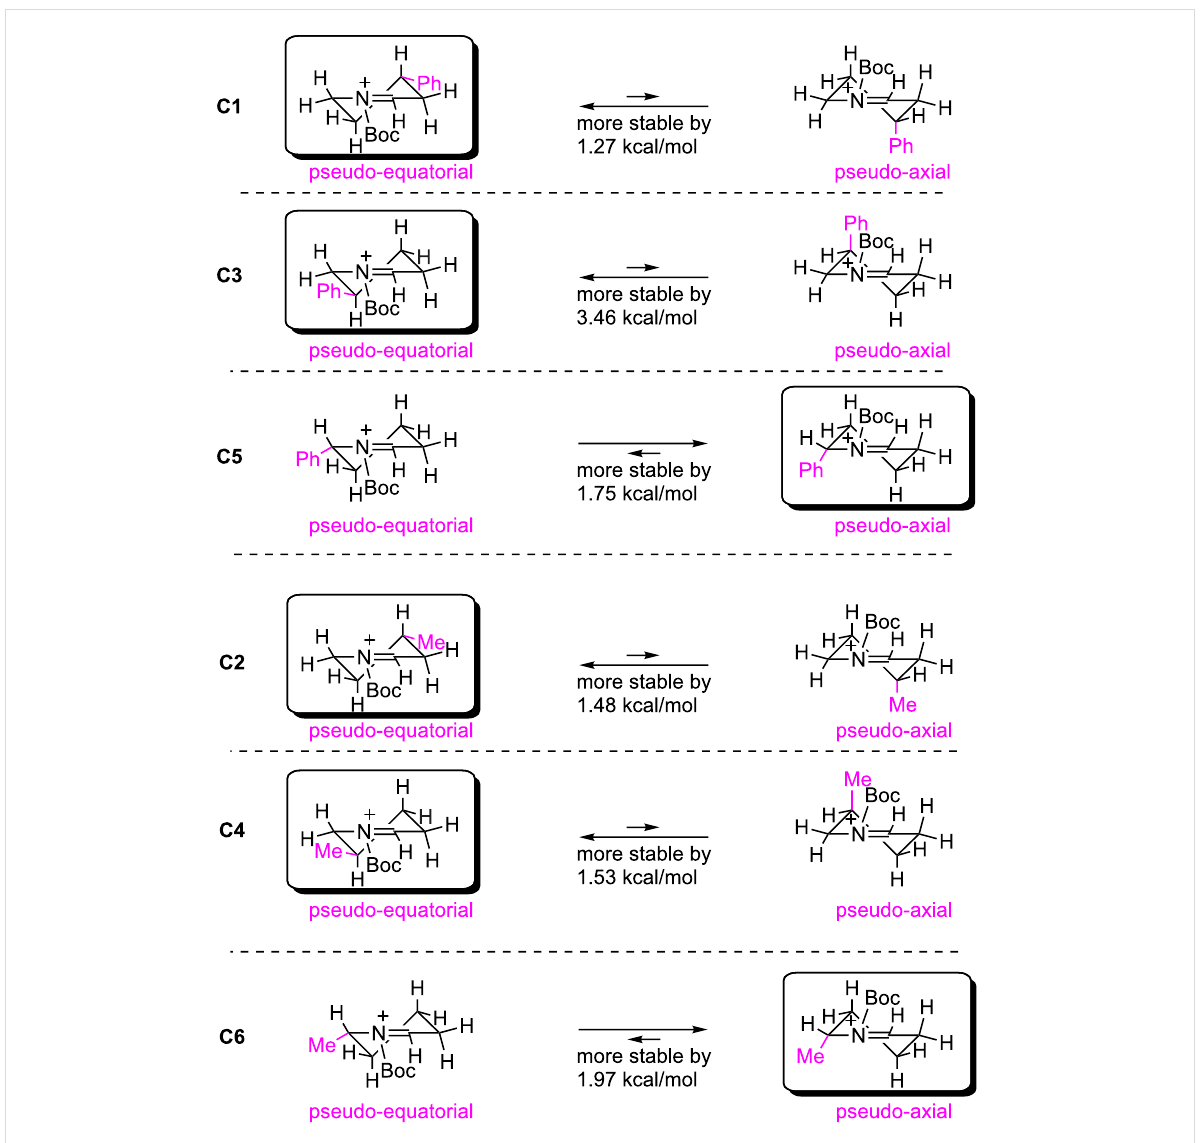
Figure 7: Comparison of Δ G for the pseudo-equatorial and pseudo-axial conformations of C1 – C6 at the B3LYP/6-31G(d)